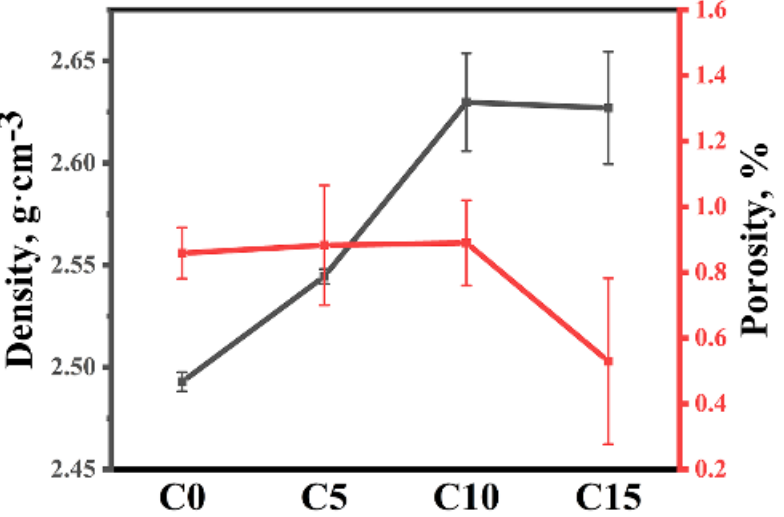
Figure 9. The open porosity and volume density of different RBBC composites.